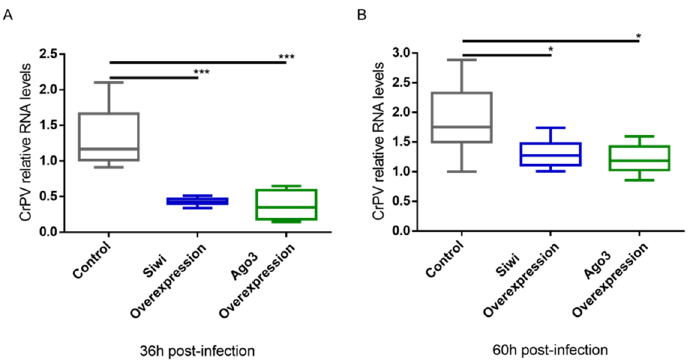
Figure 5. Relative RNA levels of Cricket Paralysis Virus (CrPV) in High Five cells upon overexpression of Siwi and Ago3. Cells were transfected with overexpression constructs containing the entire ORF of Bm-siwi and Bm-ago3 . The control group was transfected with the pEA-pac control vector containing the ORF of the puromycin resistance gene. The transfected cells were infected with CrPV (MOI10) on day 3 post-transfection. The graphs depict CrPV relative RNA levels 36 h ( A ) and 60 h ( B ) post-infection, measured by qRT-PCR. Each box depicts the interquartile range, with the inner line representing the median. The whiskers represent the minimum and maximum values. Statistical analysis (Mann–Whitney test) was performed in GraphPad Prism 6 (*** p < 0.001; * p < 0.05; n = 8).